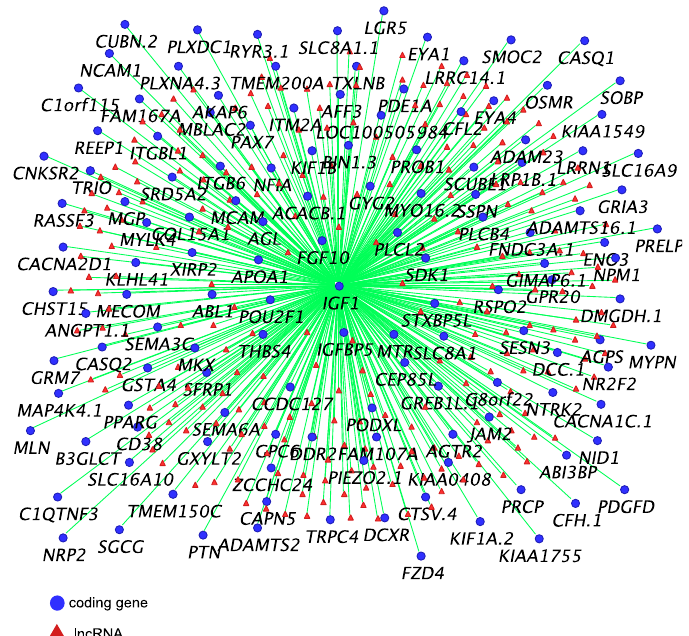
Figure 2. IGF1 co-expressed coding genes and predicted co-regulatory long non-coding RNAs (lncRNAs) (R ≥ 0.8).